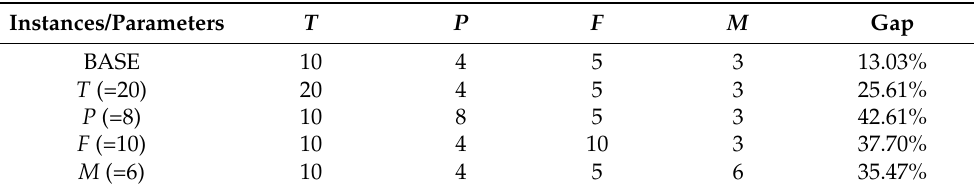
Figure 4. Evolution of the gap in the two hours computation time for the different instances tested changing the value of one parameter. (Base configuration: T = 10; F = 5; M = 3; P = 4). Table 2. Gap from the optimum solution found after two hours of computation, when the value of some parameters defining the instance